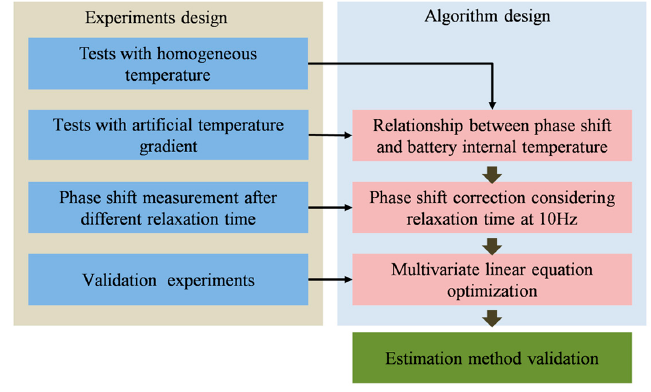
Figure 1. Implementation flowchart.